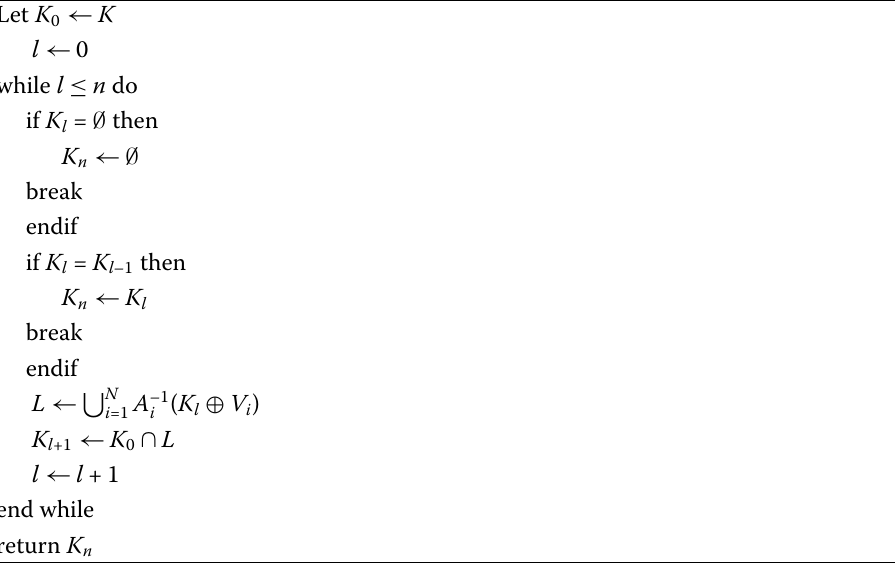
Algorithm 2 The viability kernel of discrete-time switched linear